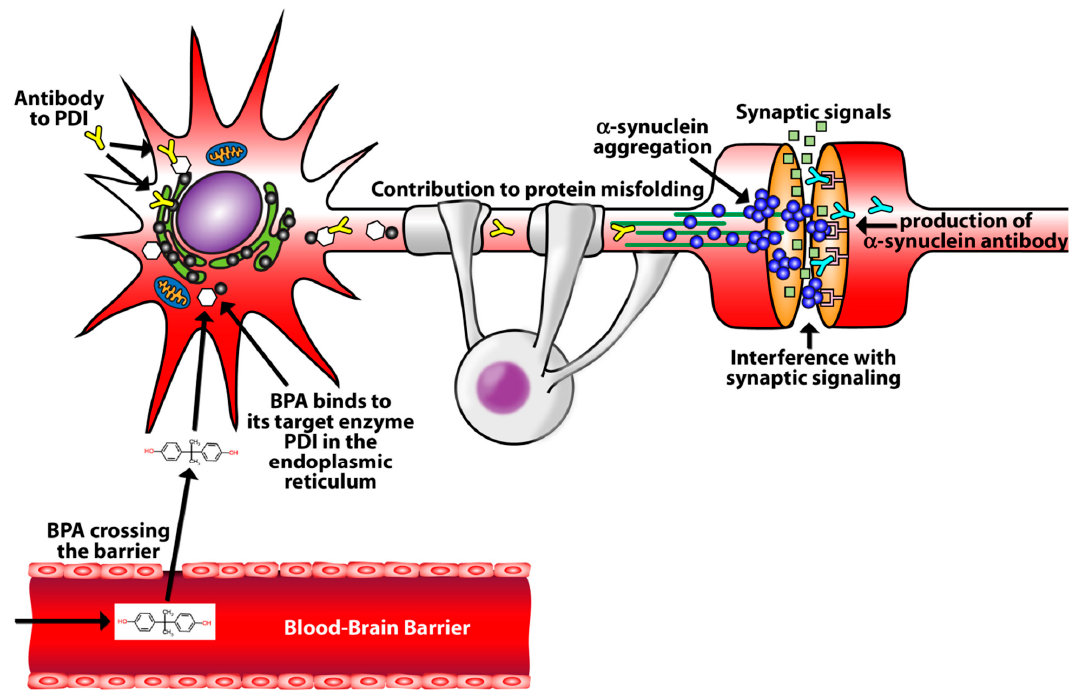
Figure 4. Theoretical mechanism of BPA promotion of alpha-synuclein aggregation and the development of alpha-synuclein antibodies. Bisphenol A crosses a breached blood-brain barrier and bind to the target enzyme PDI in the endoplasmic reticulum. The development of antibodies to PDI contributes to protein misfolding and alpha-synuclein aggregation. Antibodies form against alpha-synuclein.